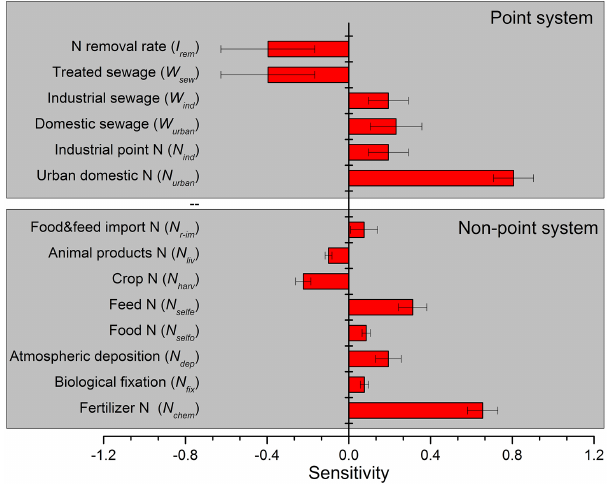
Figure 6. Sensitivity of major input terms calculated from 27 wa- tersheds in the HRB (mean ± SD). Sensitivities were calculated by applying ± 10% change in input terms of NANI. We did not test the uncertainty and sensitivity of parameters used in NANI n esti- mation, since many other similar studies clearly discussed these for all of the parameters (e.g., Swaney et al., 2015; Hong et al., 2013; Sobota et al.,